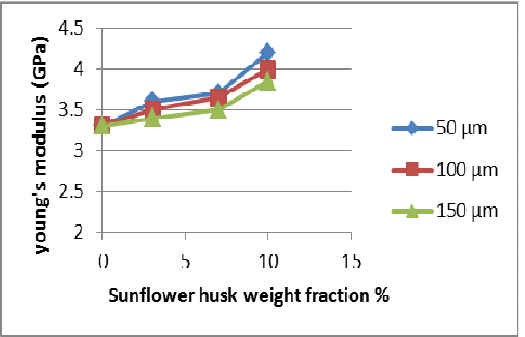
Fig. 9. Effect of sunflower husk particles on Young's modulus.